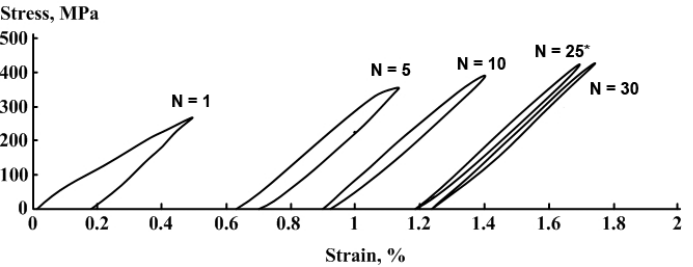
Figure 8. Stress–strain diagrams at N th loading–unloading cycle for the Fe-30Mn-5Si alloy after HR 800 (*—the beginning of the loop closure).